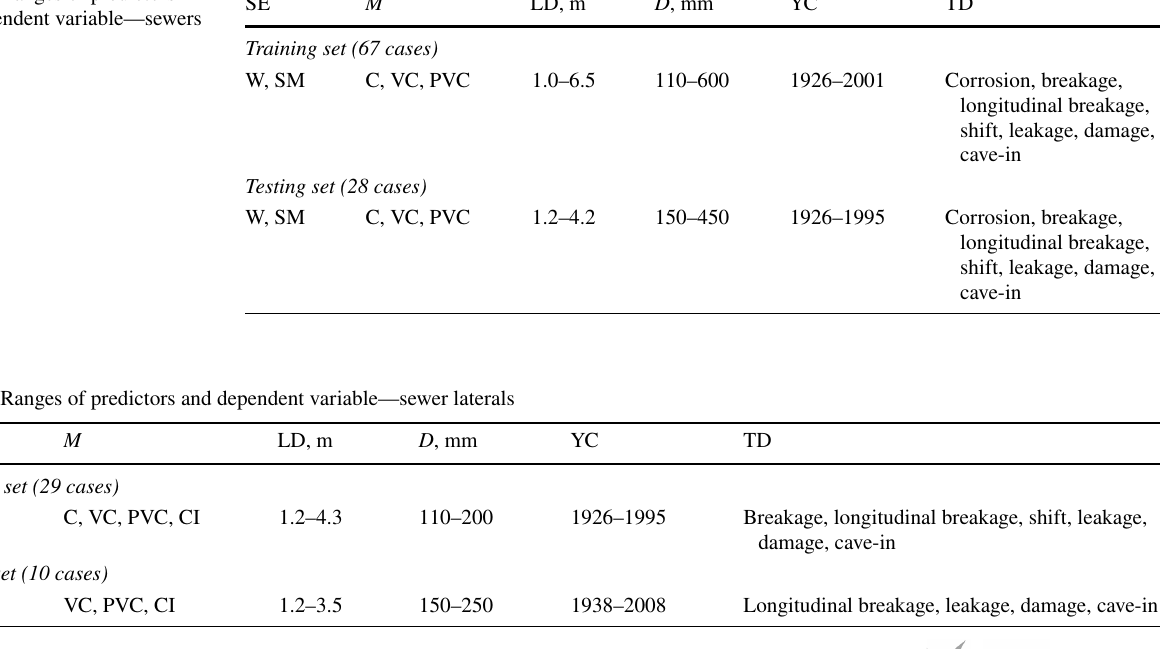
Table 1 Ranges of predictors and dependent variable—sewers